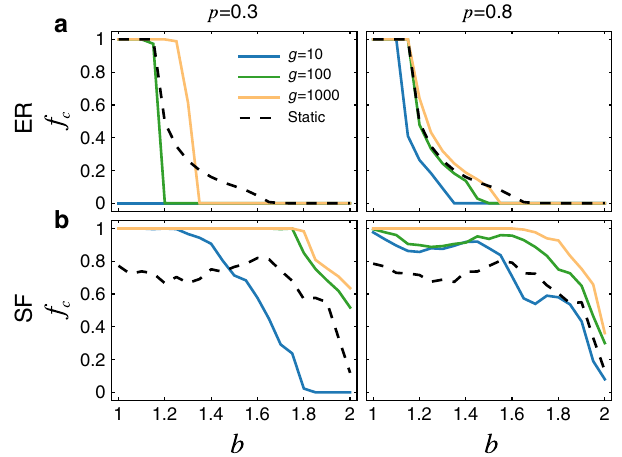
Fig. 3 Evolution of cooperation on temporal networks generated from synthetic data. Here we generate M sparse snapshots based on: a a base Erd ő s-Rényi (ER) random network 55 ; and b a base scale-free (SF) network with degree exponent 2 : 5 constructed by the static model 70 , choosing a fraction p of edges to be active within each snapshot. Note that when p is bigger, there are more links being active in each snapshot, which reduces the gap of the results obtained from temporal and static networks, while large g does not necessarily reduce the gap (Supplementary Fig. 9). Here M ¼ 100, the network size N ¼ 1000, and average degree h k i ¼ 10. The robustness of the corresponding results for other parameters and other methods of generating synthetic temporal networks has been veri fi ed (see Supplementary Fig.